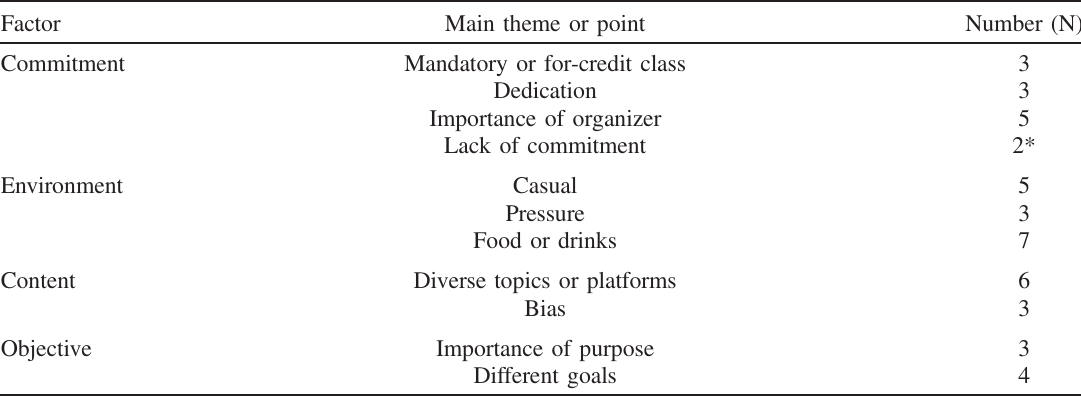
TABLE III. Summary of the four main factors affecting the success of AC which resulted from theming the codes from the interviews. The left column shows the factors, while the middle column shows the main themes or points. The right column shows the number of interviewees who discussed the aforementioned main points (total number of interviewees is